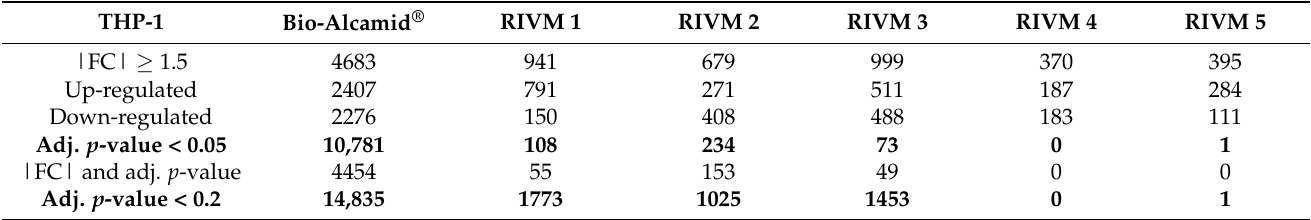
Table 1. Differentially expressed genes (DEGs) for M0 macrophages derived from THP-1 cells exposed to RIVM preparations and Bio-Alcamid ® extracts. The number of genes significantly different compared to non-treated control cells is indicated in bold.